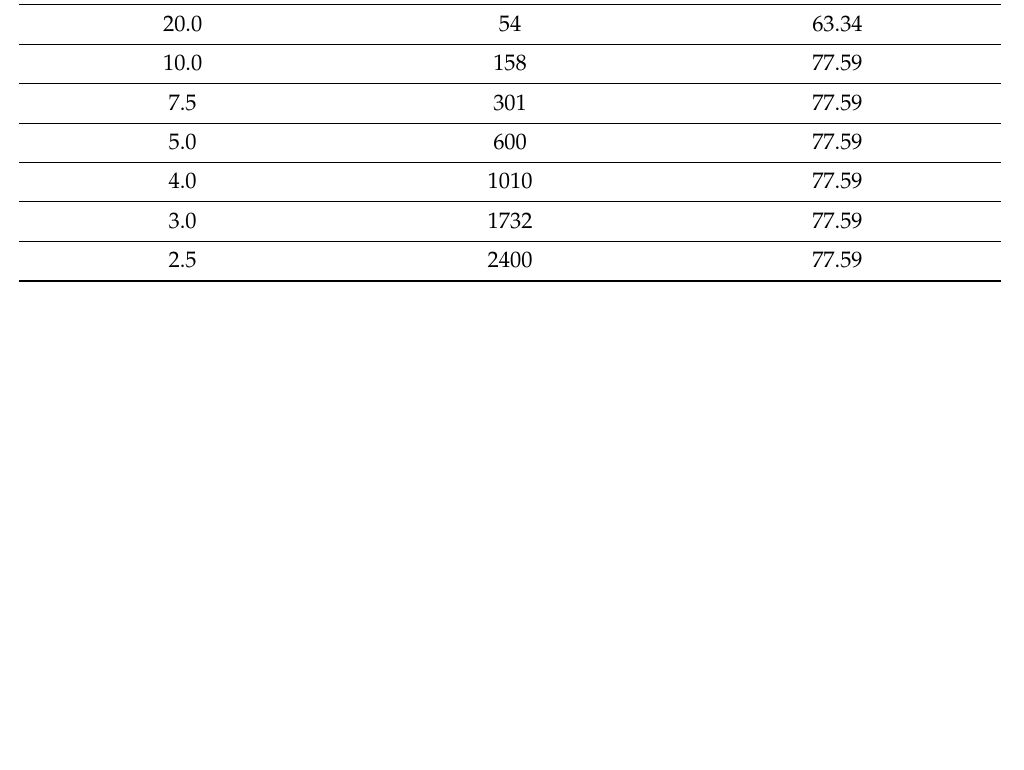
Table 10. Mesh convergence test for the validation of the computational model by Narayanan and Chow [29]. Element Size